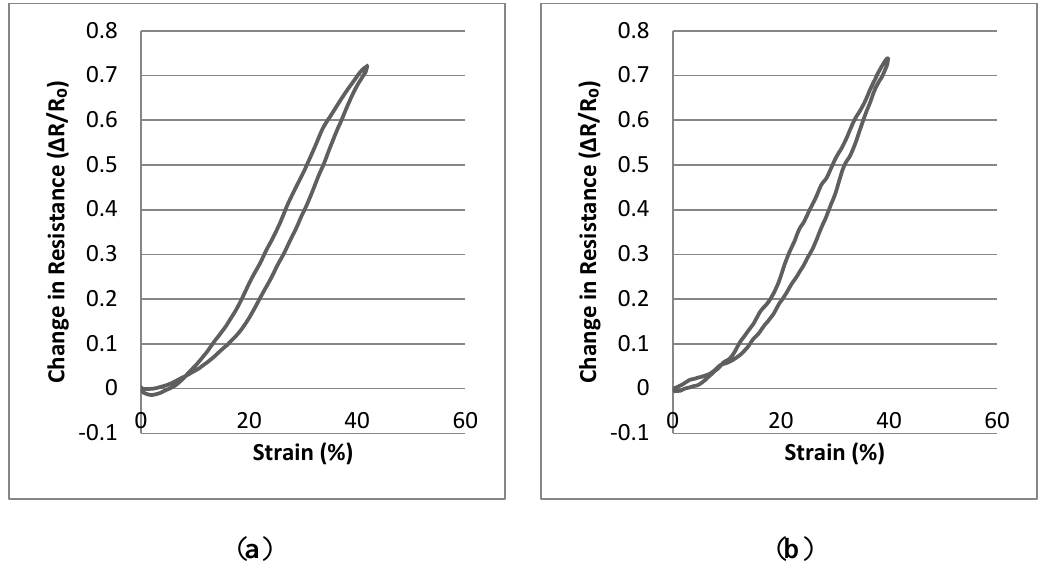
Figure 8. Relative change in resistance-strain graphs of the sensors ( a ) Sensors realised with six conductive courses; ( b ) Sensors realised with four conductive